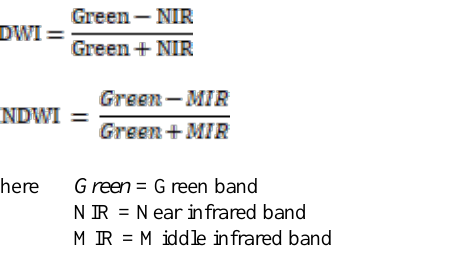
Figure 2: The results of radiometric and atmospheric corrections on Landsat-8 OLI images from 2018 (before flooding, left image) and 2019 (after flooding, right image).